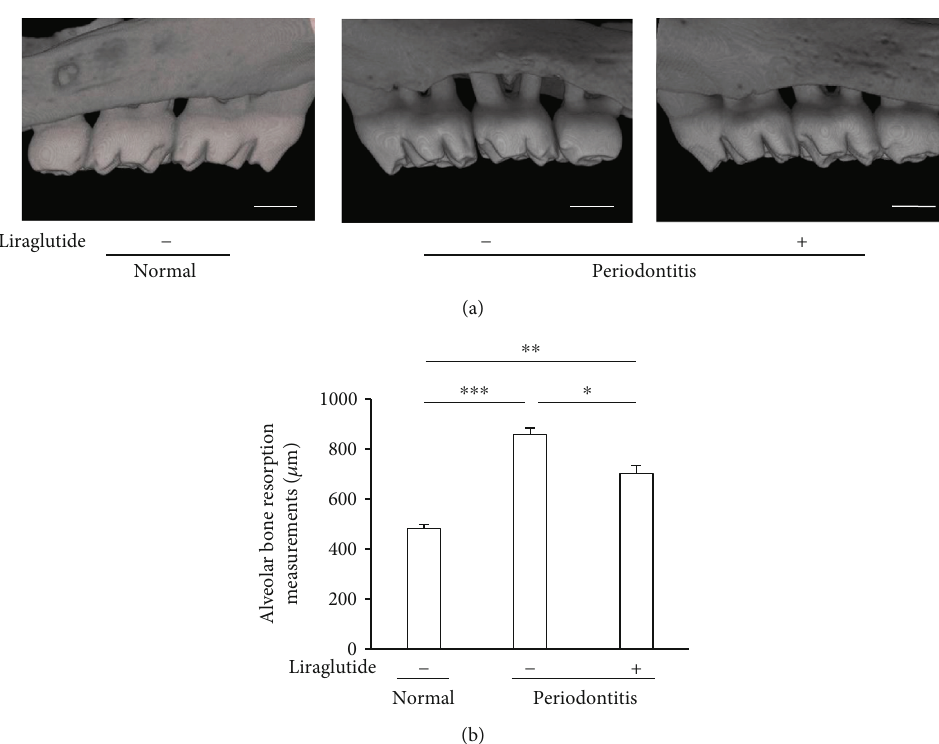
Figure 3: Liraglutide reduced bone resorption in rats with periodontitis. (a) Generated three-dimensional images of alveolar bone. Scale bar = 1 mm. (b) Bone resorption was calculated as the distance from the buccal cementoenamel junction to the alveolar bone crest. The results are expressed as the mean ± SEM ( n = 8 -10). ∗ P < 0 : 05 , ∗∗ P < 0 : 01 , and ∗∗∗ P < 0 : 001